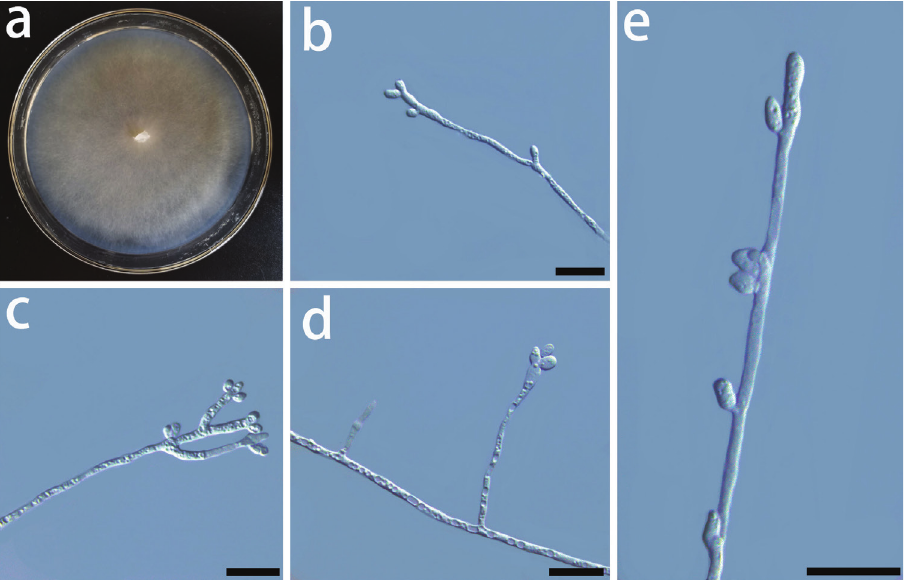
Figure 11. Morphological characters of asexual structures of Graphilbum translucens sp. nov. a fourteen- day-old culture on MEA b-e conidiophores and conidia. – Scale bars: 10